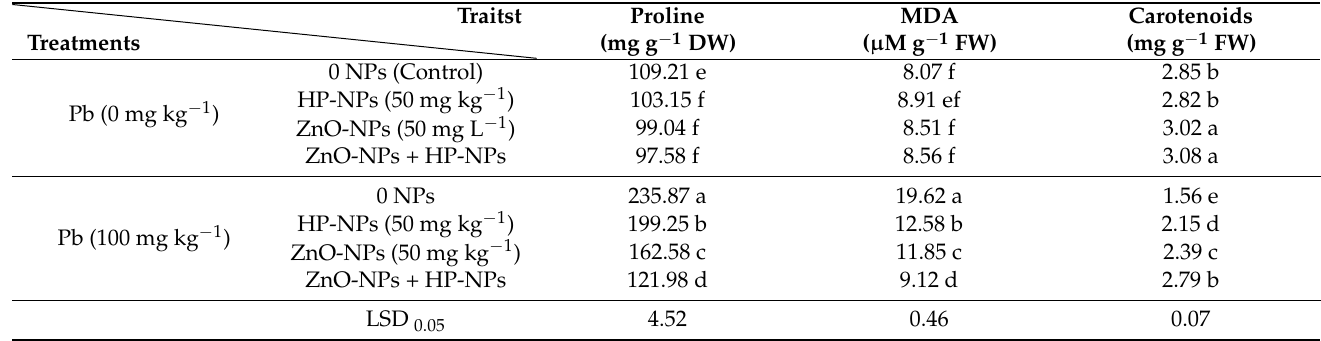
Table 3. Effects of nano-hydroxyapatite NPs (NH NPs), zinc oxide NPs (ZnO-NPs), and their combi- nations on proline, malonaldehyde (MDA), and carotenoids in maize grown in soil contaminated with lead (Pb).